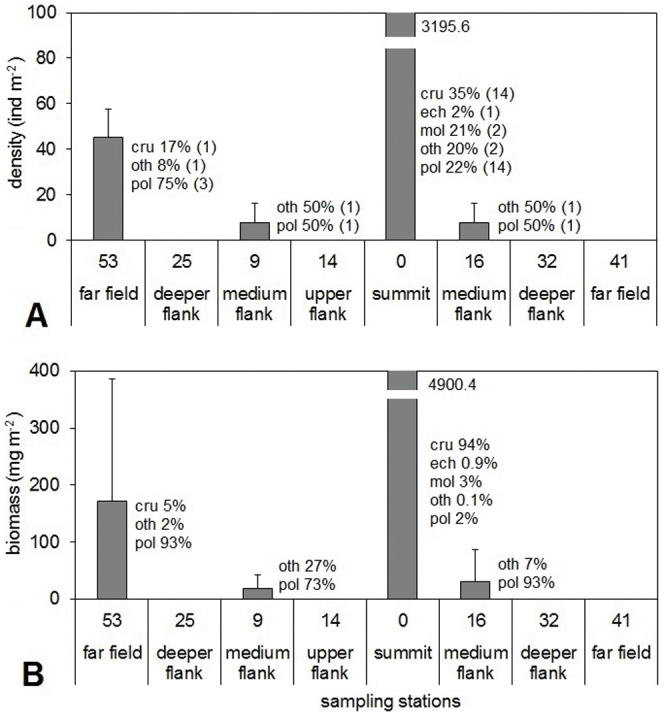
Average macrofaunal abundance and biomass and the contribution of each taxonomical group (cru: crustacean, pol: polychaetes, mol: molluscs, ech: echinoderms and oth: others) for each station.Values averaged over independent replicates: bars denote standard error. A: abundance (individuals m−2), in brackets the number of taxa, B: biomass(µg m−2, the values have been calculated with the gravimetric method).